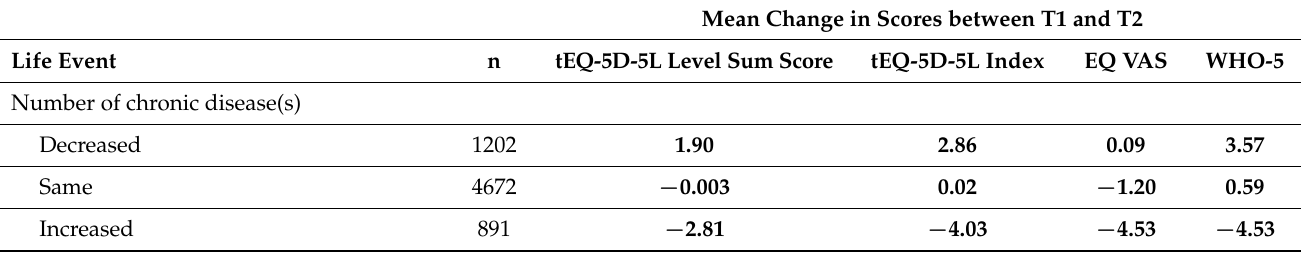
Table 4. Mean change in health-related quality of life and mental well-being by life event. Mean Change in Scores between T1 and